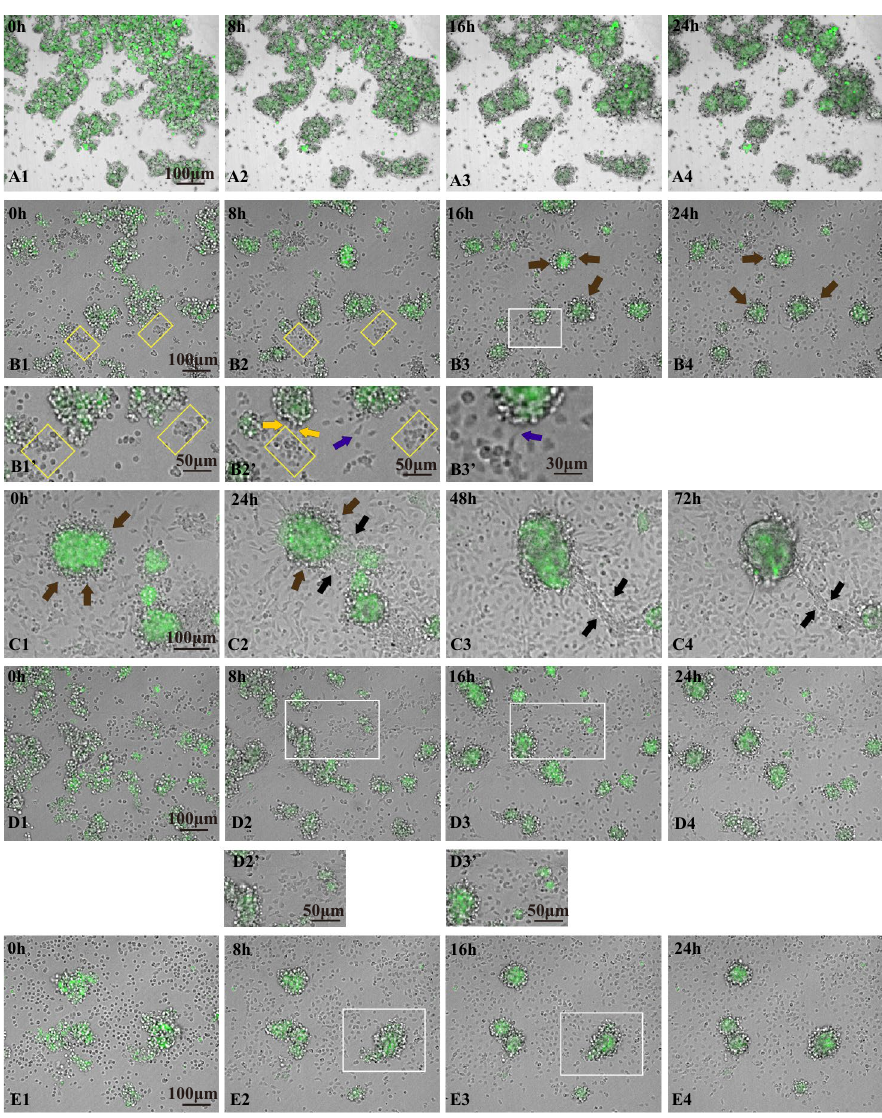
Figure 4. Live cell imaging shows interaction of CD34 + cells and ALCs. Merged figures of GFP and bright field images are shown. All photographs shown here are slice snapshots except ( A1 – A4 ) which are snapshots of MIPs. ( A1 – A4 ) Behavior of purified LCs only (GFP-positive, mostly ALCs) recorded by time-lapse video camera during 24 h. ( B1 – B4 ) Behavior of LC-CD34 + cell-aggregates and CD34 + cells which were spread around the aggregates and adhered to the dish. Areas surrounded by yellow boxes in ( B1 ) and ( B2 ) show regions where CD34 + cells that adhered to each other gradually spread. Enlarged figures around the yellow boxed areas in ( B1 ) and ( B2 ) are also shown in ( B1’ ) and ( B2’ ). Orange arrows in ( B2’ ) show CD34 + cells which are just plunging into LC-CD34 + cell-aggregates. A purple arrow in ( B2’ ) shows a CD34 + cell which was going toward a LC-CD34 + cell-aggregate. Brown arrows in ( B3 ), ( B4 ), ( C1 ) and ( C2 ) show round CD34 + cells that attached around LC-aggregates. ( B3’ ) is the enlarged figure of the white-boxed area in ( B3 ), and a purple arrow shows an example of a CD34 + cell which extended filopodia and was just touching the LC-CD34 + cell-aggregate. ( C1 – C4 ) are an example showing that some LC-CD34 + cell-aggregates were connected by cytoplasmic processes extending from the 2 aggregates (black arrows in C2 – C4 ) and coalesced into one aggregate ( C3 , C4 ). In this case, starting time was 17.5 h following inoculation. ( D1 – D4 ) show an example of the behavior of CD34 + cells treated with VCAM1 antibody. White boxed areas ( D2 , D3 ) and their enlarged figures ( D2’ , D3’ ) show the typical behavior of CD34 + cells. ( E1 – E4 ) show an example of the behavior of CD34 + cells treated with antibodies against α4, α9 and β1